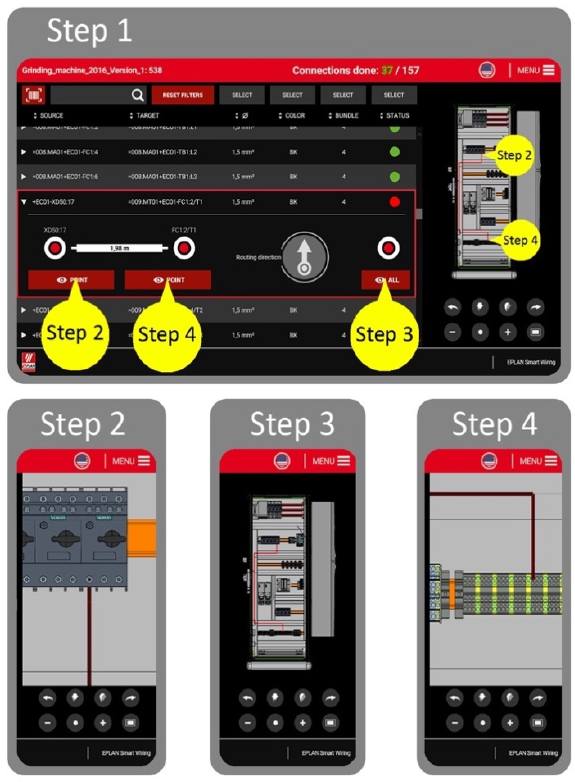
Figure 3. EPLAN Smart Wiring (ESW) application (Step 1) with 3 zooms of the 3D graphics, showing the zoomed connection point (Step 2, Step 4) or whole wiring routing (Step 1, Step 3).